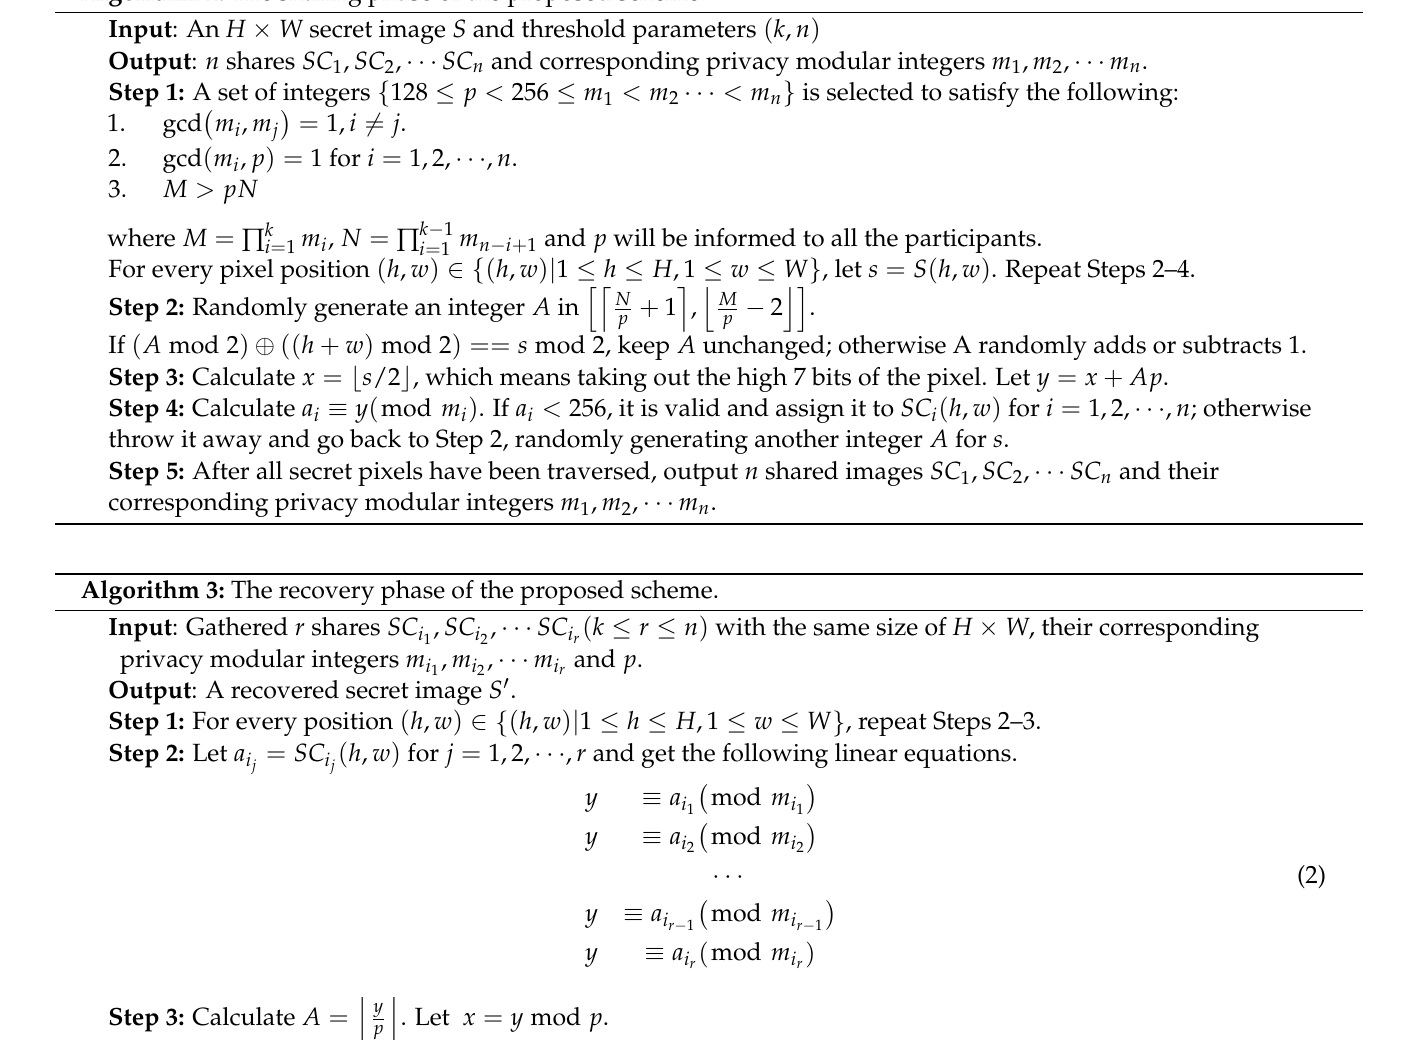
Algorithm 2: The sharing phase of the proposed scheme.